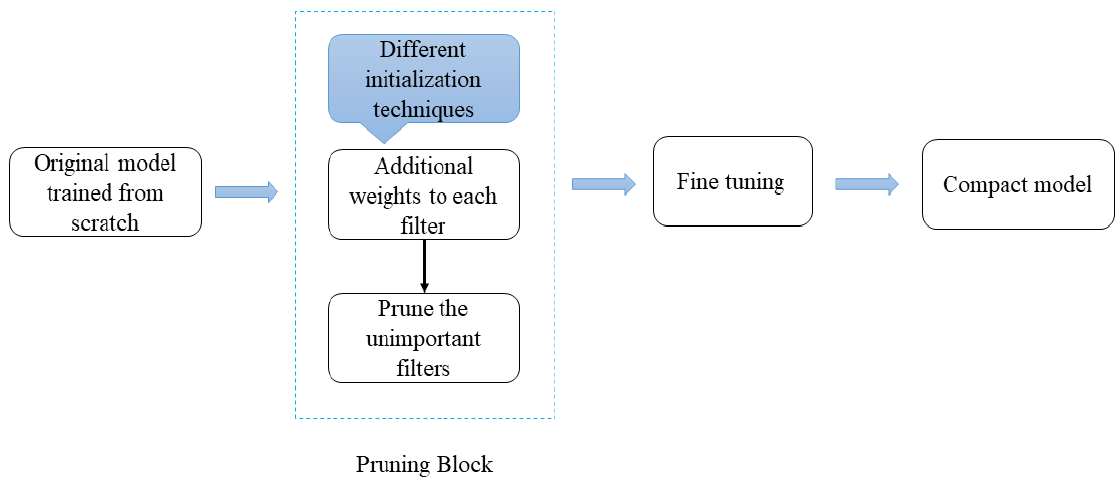
Figure 1. Overall procedure for the proposed filter pruning.